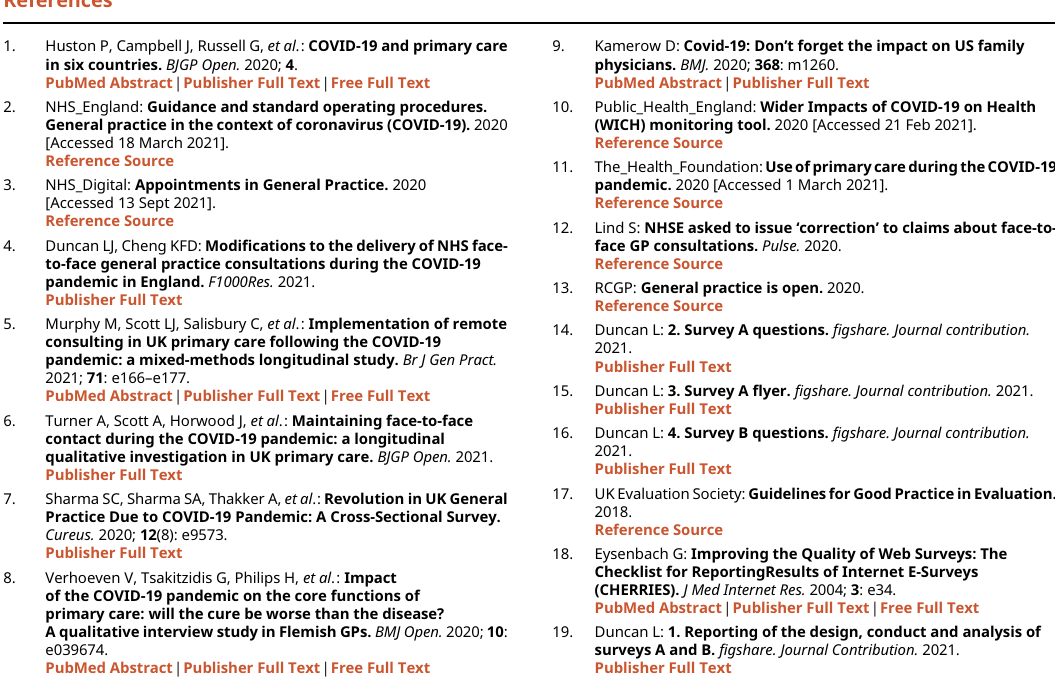
Figshare: Survey B questions, https://doi.org/10.6084/m9.figshare.14269478.v1 16